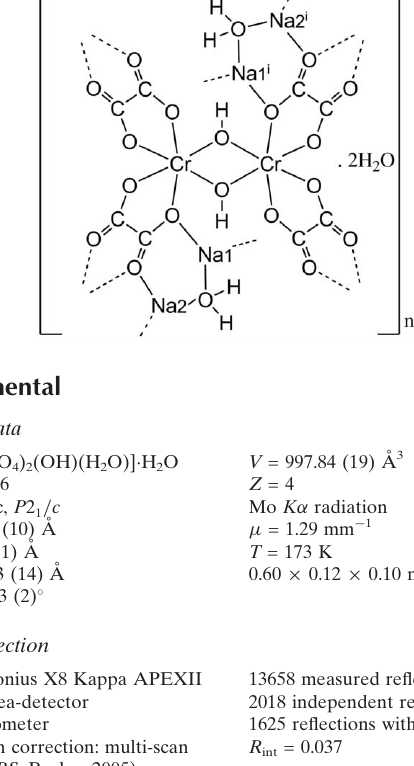
Data collection Bruker–Nonius X8 Kappa APEXII CCD area-detector diffractometer Absorption correction: multi-scan